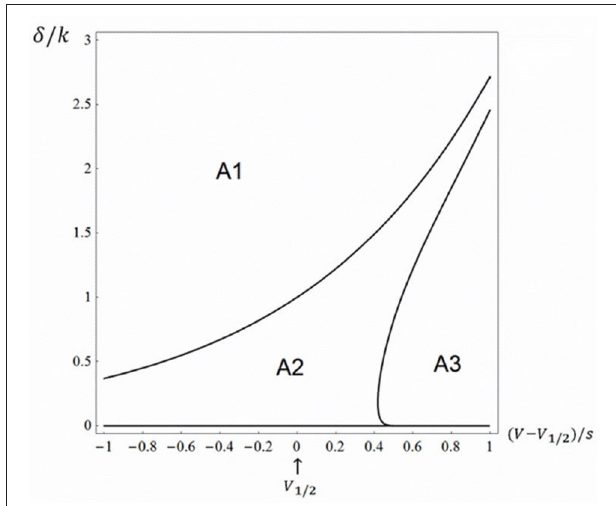
FIGURE 2 | Topologically equivalent regions in the rate-potential plane. The three-state model (Equation 1) at K d -concentration of the blocking drug (i.e., γ = δ ). A1 represents an area in which there is no open probability peak and the steady state value decreases with potential approaching a value of a half, A2 represents an area in which there is a peak and the relative amplitude decreases with potential and A3 represents an area in which there is a peak, but the relative amplitude increases with potential, approaching a value of